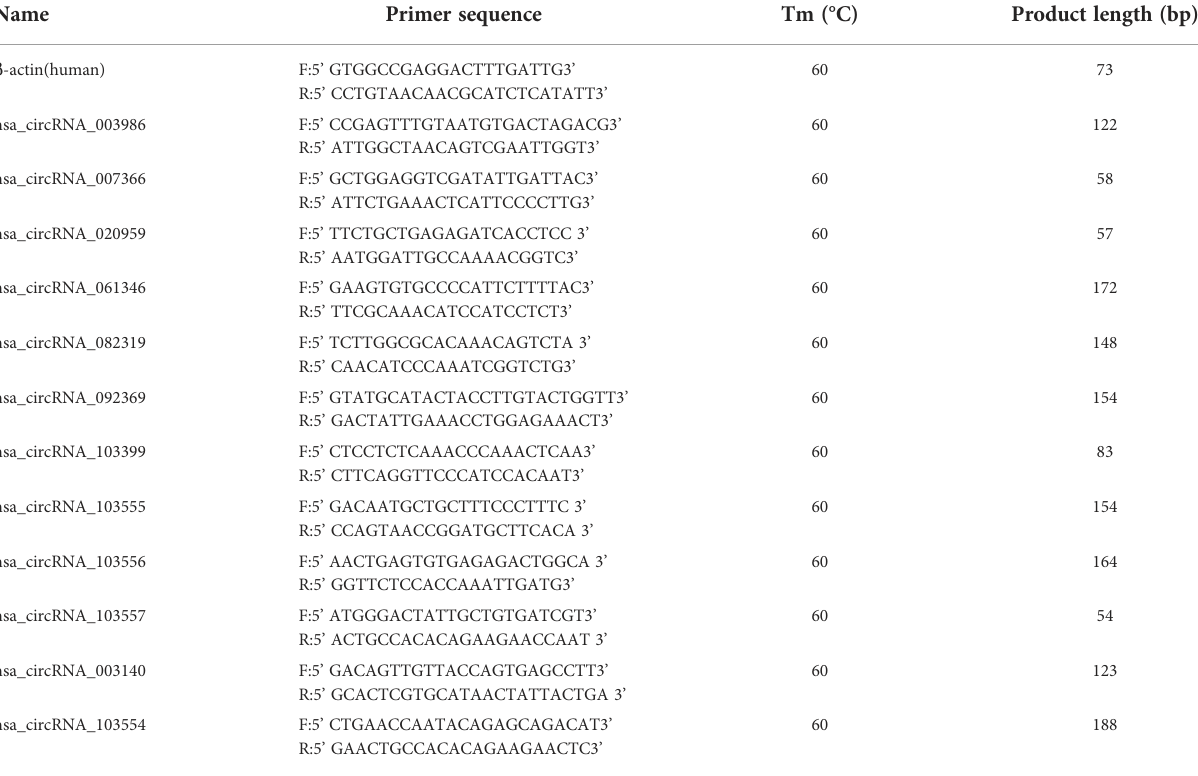
TABLE 2 List of primer sequences of the circRNAs for real-time polymerase chain reaction